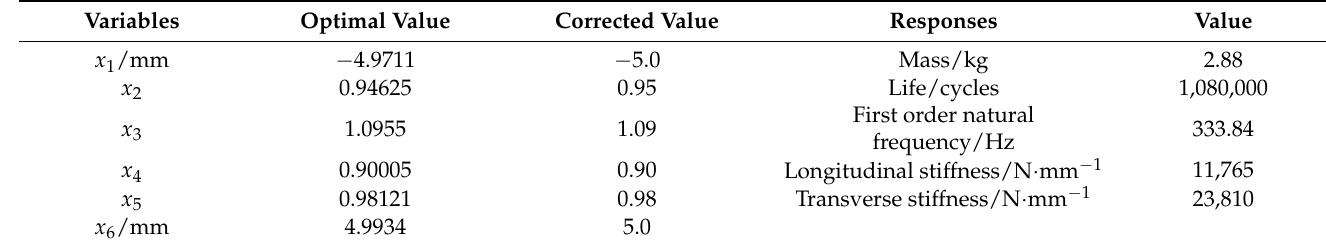
Figure 12. Pareto front. Table 4. Deterministic multi-objective optimization results.